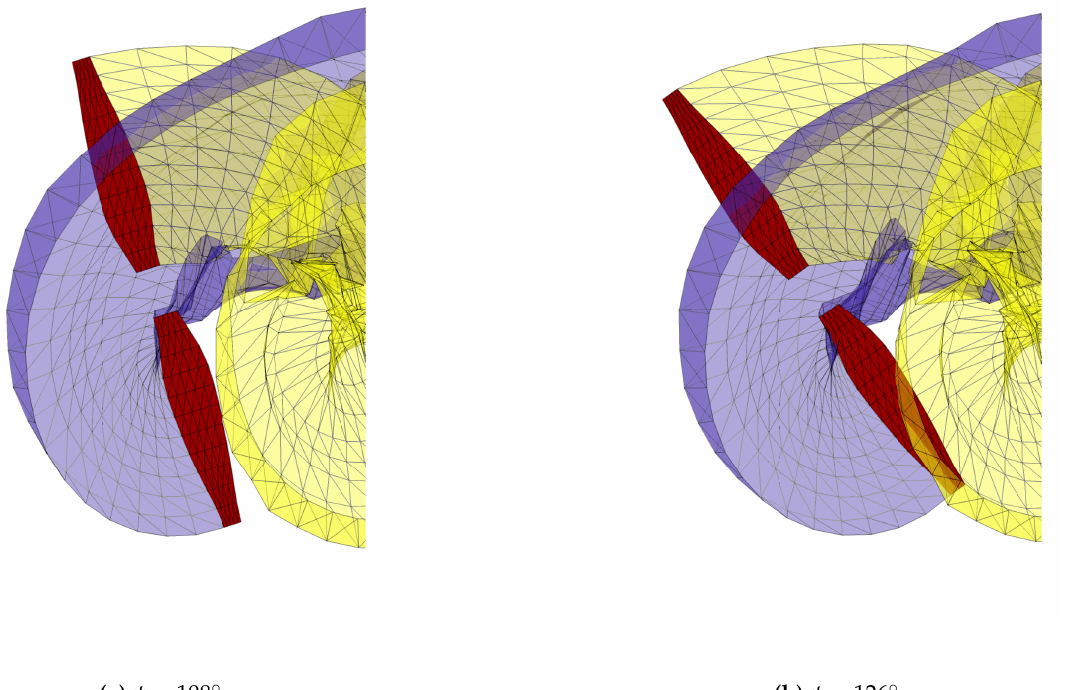
Figure 13. Rotor and wake visualization of the APC 12x5.5MR ( α tpp = 0 ◦ , µ ∞ = 0.25) as modeled in the DDE method.